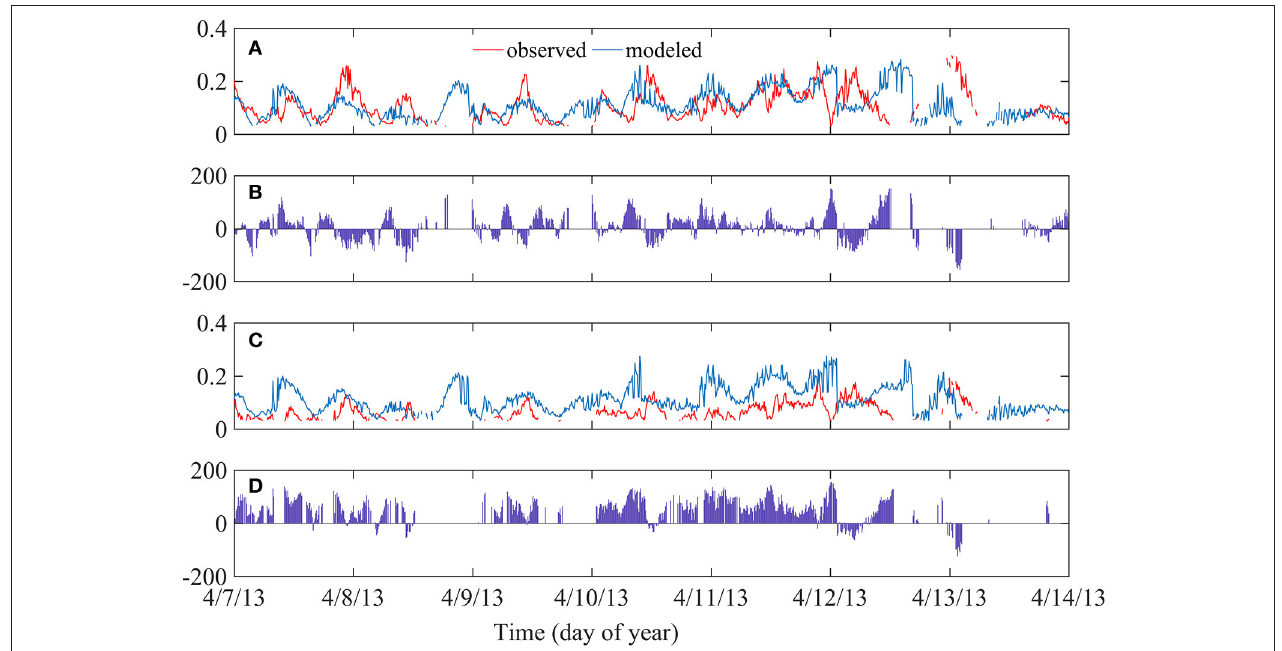
FIGURE 8 | (A) Significant wave height comparison between Young and Verhagen model output (blue) and in situ observation values (red) at the unvegetated site during April 2013. (B) Time series of percent attenuation (difference) between measured and modeled wave height at the unvegetated site. Positive attenuation signifies modeled wave heights were greater than observed wave heights. (C) Wave height comparison between model output (blue) and observed values (red) at the Center seagrass site during April 2013. (D) Time series of percent attenuation between measured and modeled wave height at the seagrass site.